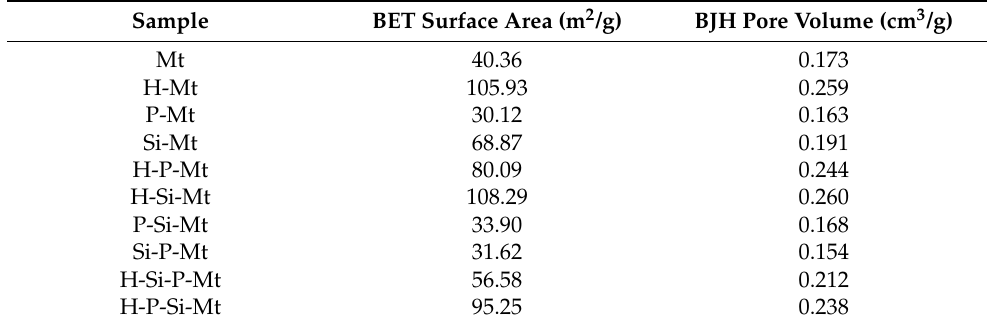
Table 1. Results of nitrogen adsorption–desorption analysis.